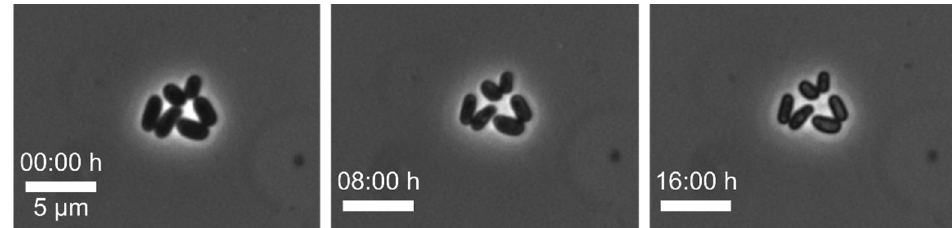
Figure 9. Microscopic images of C. glutamicum where no growth is seen in the chip over the whole cultivation time (scale bar = 5 μ m).